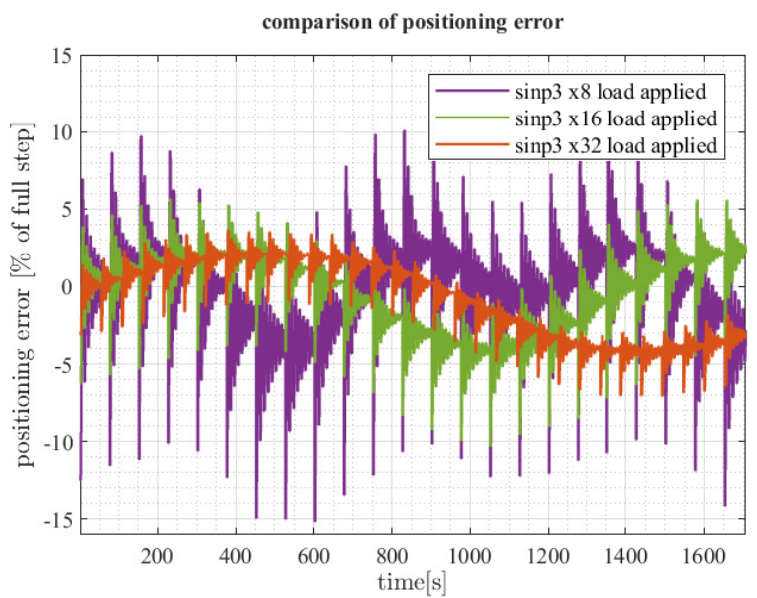
Figure 26. Influence of microstepping resolution for the selected p -circle signal on shaft position error. Time range is chosen so as to include one full step of recorded data with lowest angular velocity.